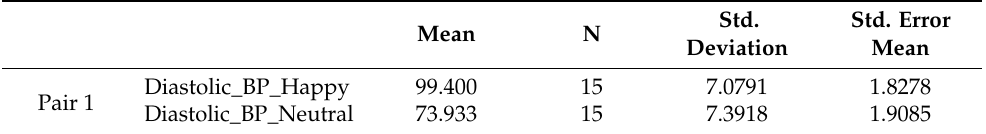
Table 6. Paired samples statistics for diastolic BP (happy to neutral state).